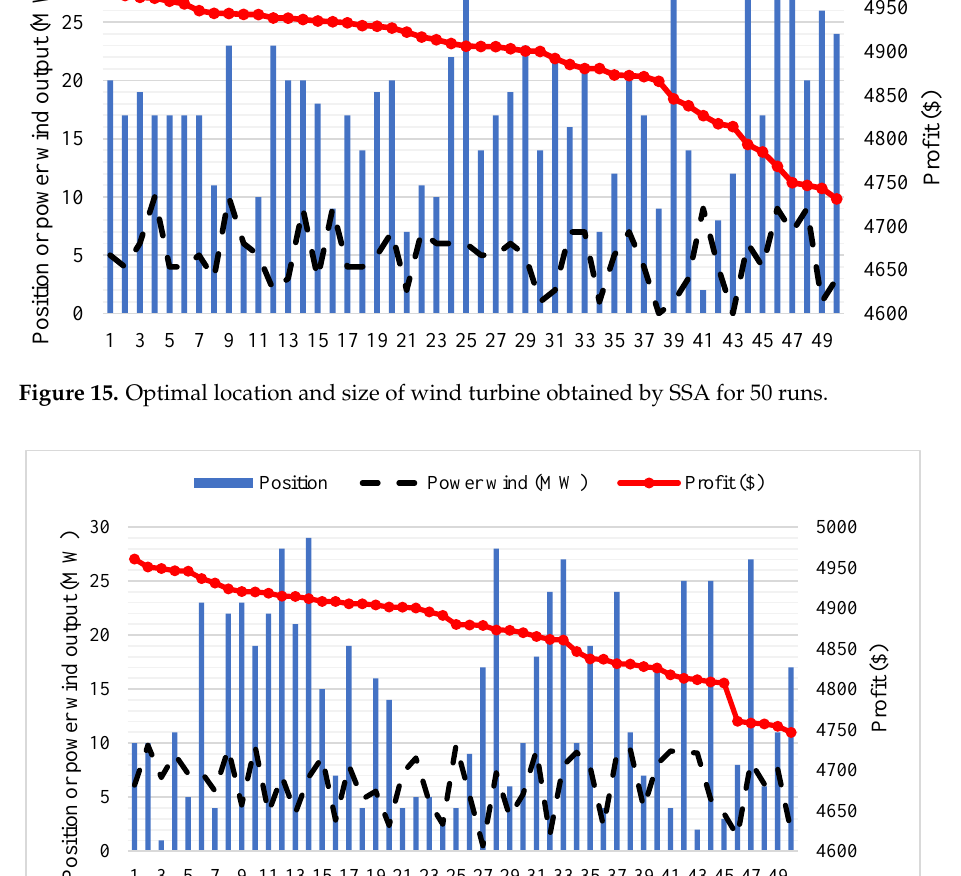
19 of 28 Figure 13. Optimal location and size of wind turbine obtained by WCA for 50 runs.